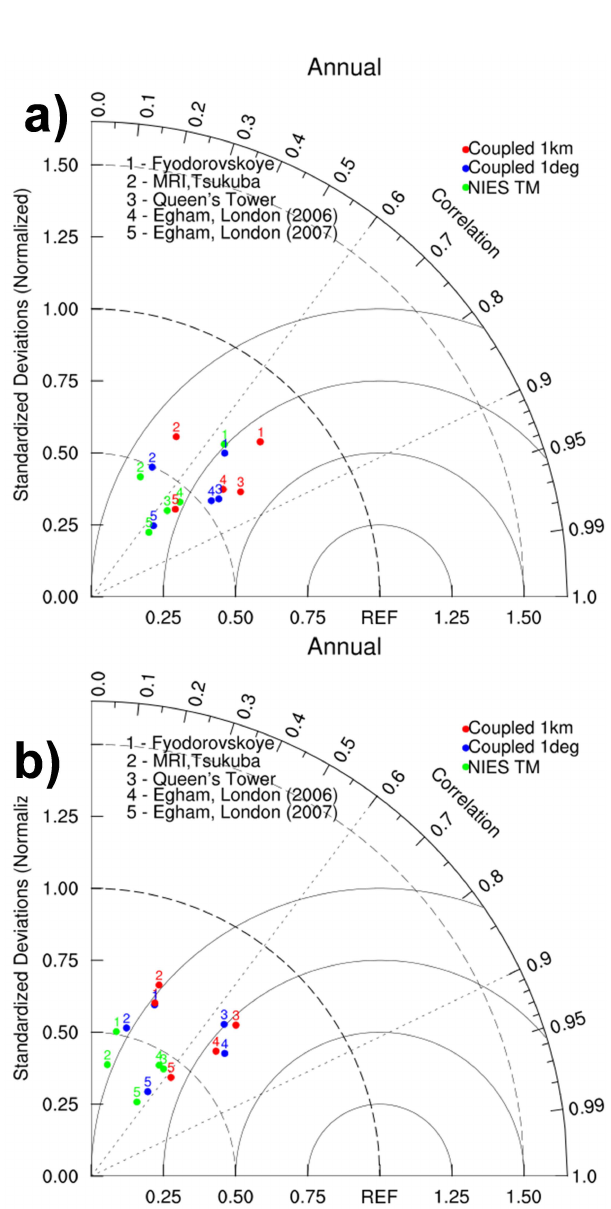
Fig. 2. Taylor diagram showing the simulated results: (a) without being deseasonalized; (b)